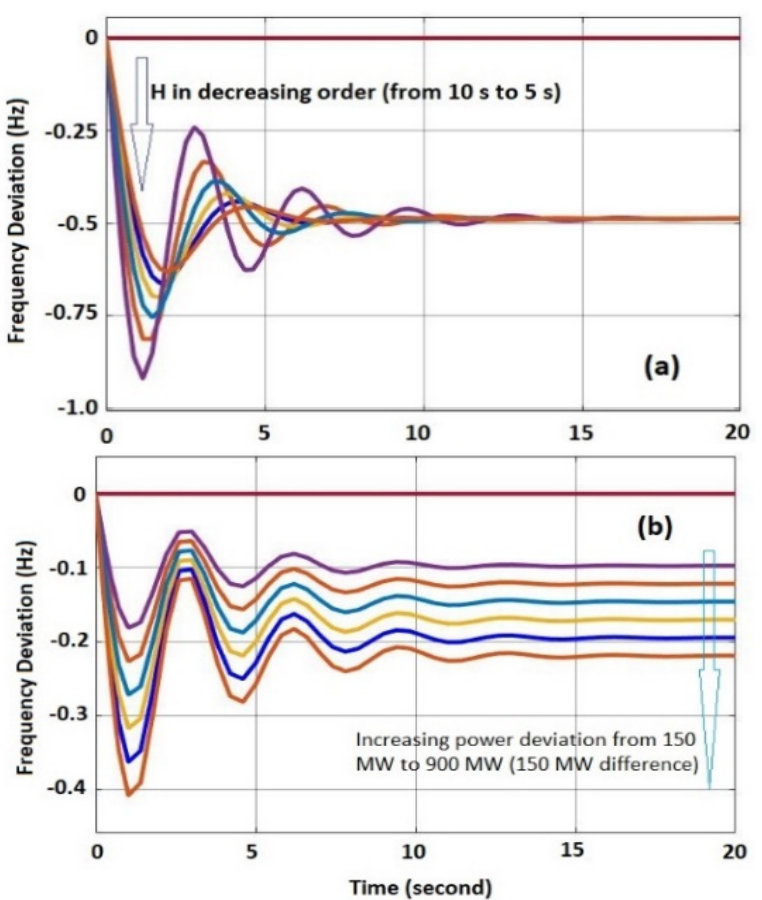
Figure 10. Frequency dynamics for ( a ) different inertial constants and ( b ) different power devia- tions.